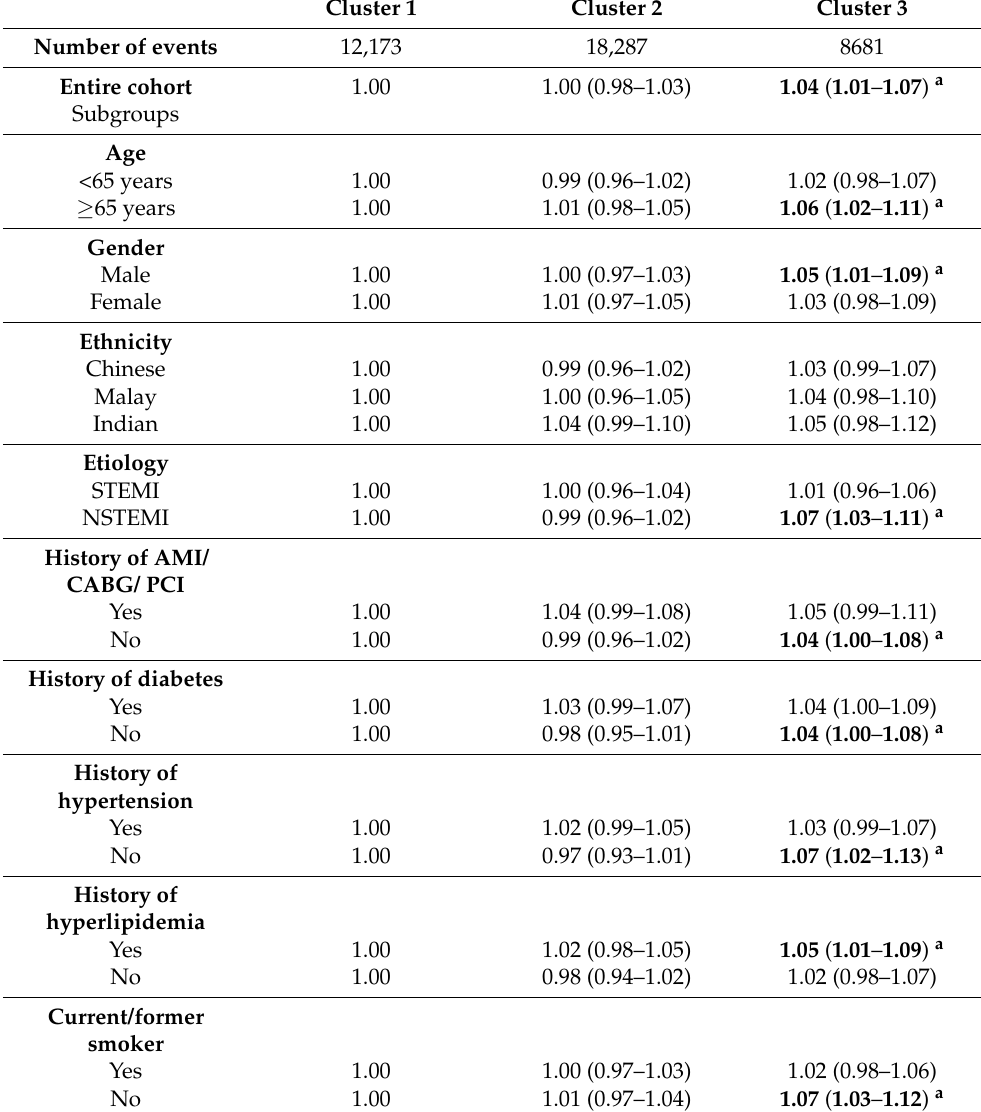
Table 3. Incidence risk ratios of AMI across the three